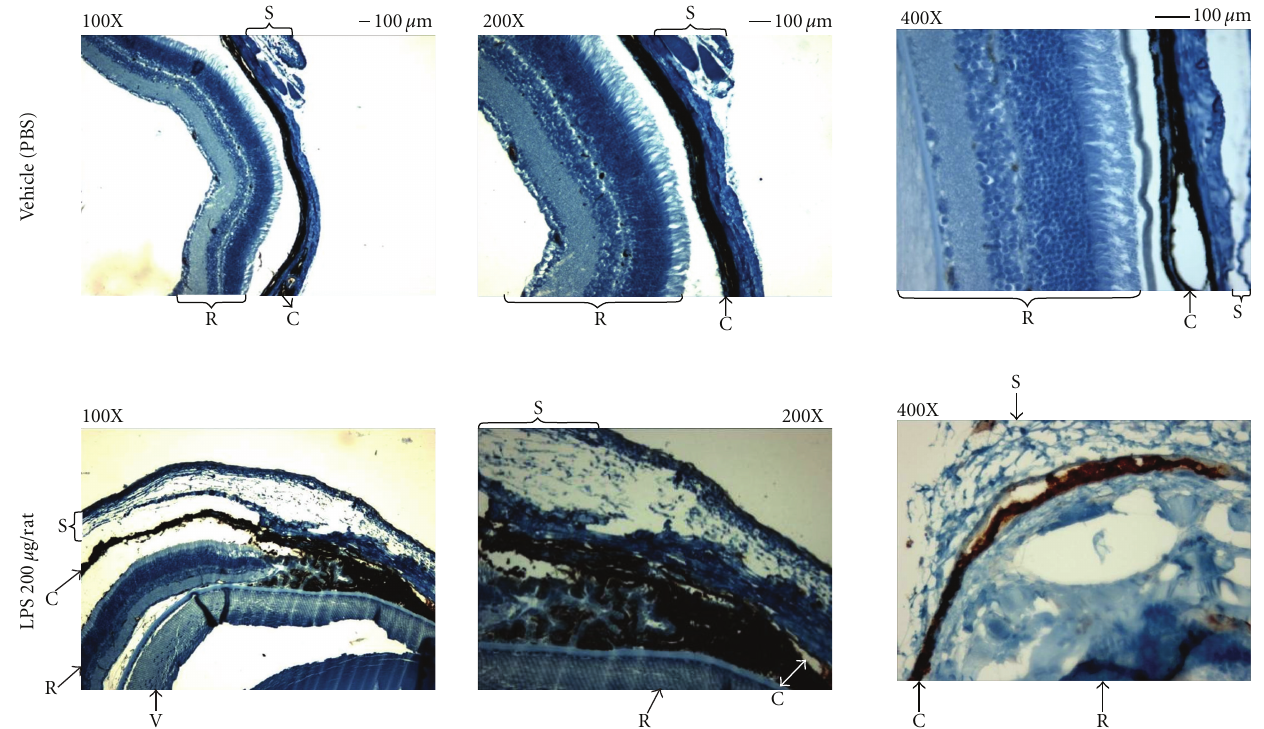
Figure 2: Sections showing representative immunohistochemistry of rats eye tissues treated with vehicle (PBS) and LPS (200 μ g/rat). Magnification was 100x, 200x, and 400x. C = choroid; Cb = ciliary body; R = retina; S =